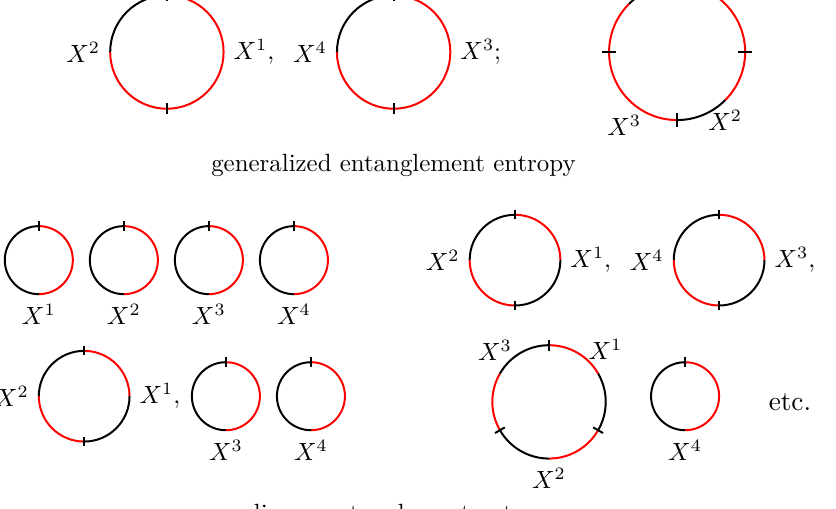
Figure 2 . Boundary conditions and degrees of freedom for the ordinary and generalized entangle- ment entropy in the example of N = 4 , n = 2 and ˆ k = 1 . A circle in the figure with m field labels attached to it corresponds to a cycle of length m in the group element defining the twisted boundary conditions. The red intervals mark the degrees of freedom for which the entanglement entropy is defined. For the ordinary entanglement entropy, we consider all twisted sectors and all fields on the same interval [0 , z 2 ] . For the generalized entanglement entropy, we consider only cycles of length m ∈ 2 N and the intervals as given as [0 , 2 π ] for X 1 , 3 and [0 , z 2 ] for X 2 , 4 . The boundary conditions effectively connect the intervals for the X 1 , X 2 as well as the X 3 , X 4 fields into a single interval of size 2 π ˆ k + z 2 . Note that we draw only one realization of each twisted sector. Symmetrization over the S N group would yield further realizations by exchanging the field labels in the above